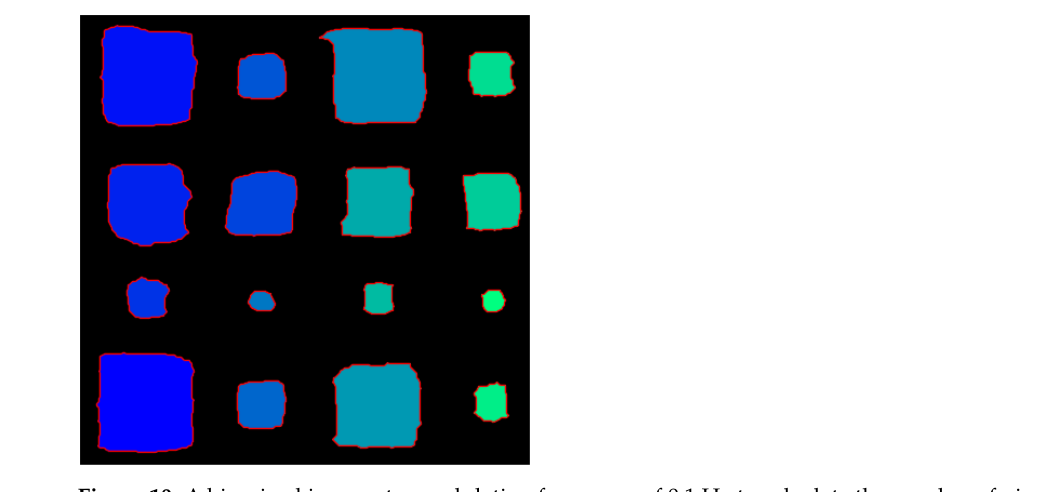
Figure 10. A binarized image at a modulation frequency of 0.1 Hz to calculate the number of pixels in a region. Table 2. Estimation of the number of pixels and error for water ingress.